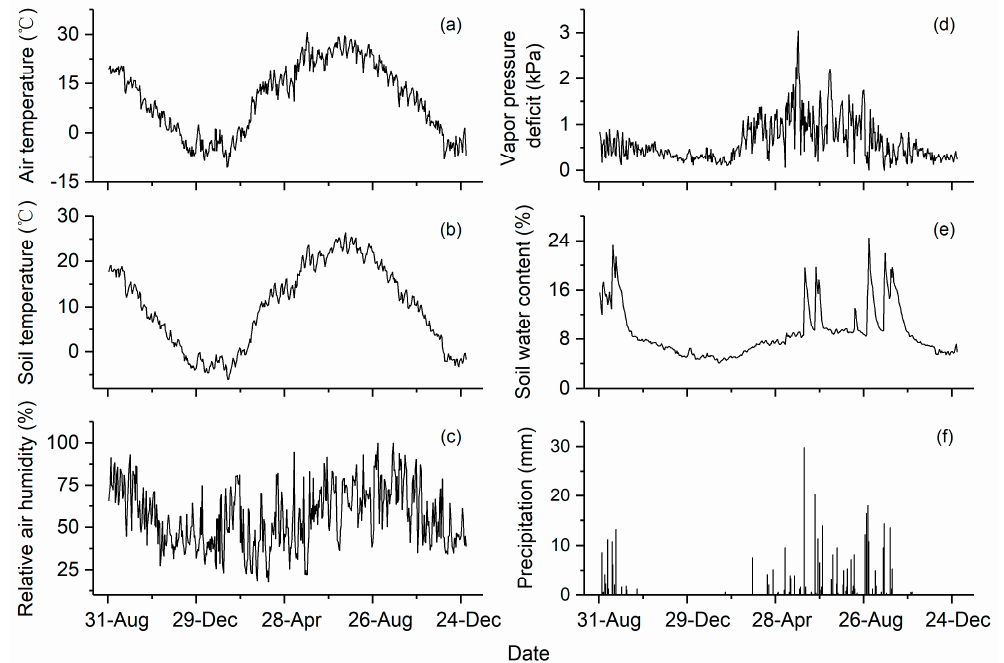
Figure 2. Daily climatic conditions at the study site from 1 September 2013 to 31 December 2014. ( a ) Mean daily air temperature (T a ); ( b ) mean daily soil temperature (T s ); ( c ) relative air humidity (RH); ( d ) vapor pressure deficit (VPD); ( e ) soil water content (SWC); and ( f ) Precipitation (P).